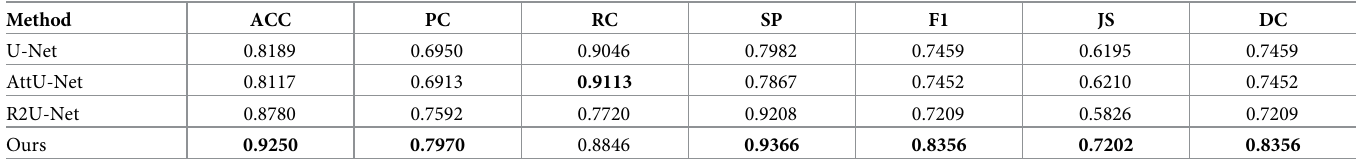
Table 4. Comparison with supervised semantic segmentation